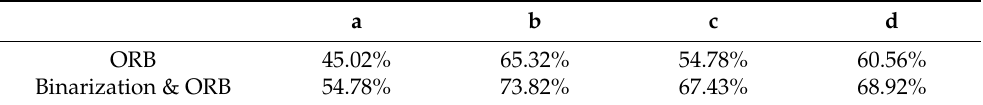
Table 1. Feature descriptor pair matching accuracy.